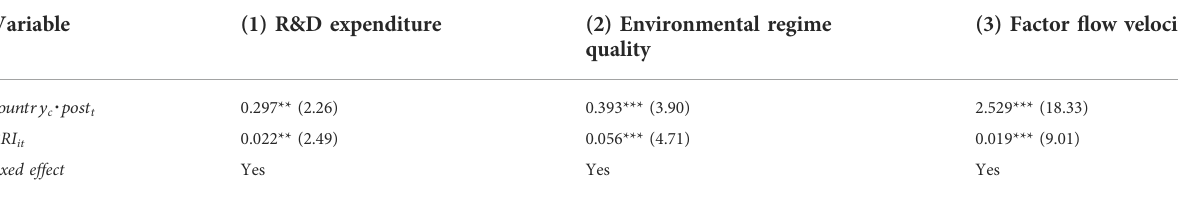
TABLE 7 Results of the mechanism test.